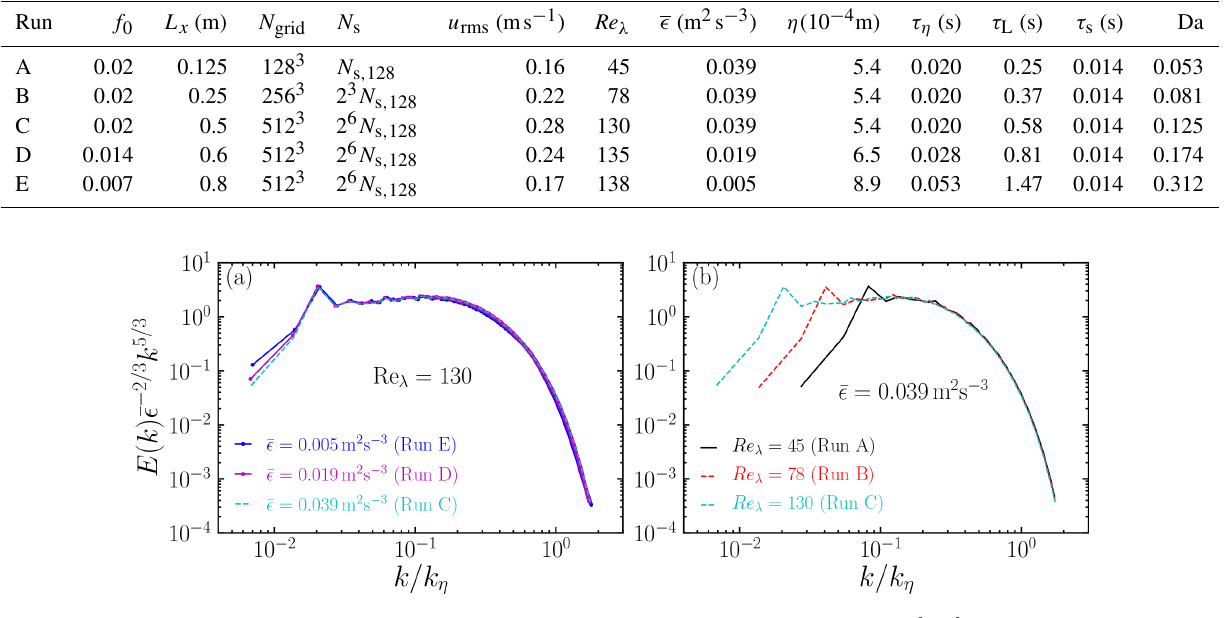
Figure 1. Time-averaged kinetic-energy spectra of the turbulence gas flow for (a) different (cid:15) = 0 . 005m 2 s − 3 (dash-dotted blue line), 0.019 (dash-dotted magenta line), and 0.039 (dashed cyan line) at fixed Re λ = 130 (see runs C, D, and E in Table 2 for details) and for (b) different Re λ = 45 (solid black line), 78 (dashed red line), and 130 (dashed cyan line) at fixed (cid:15) = 0 . 039m 2 s − 3 (see runs A, B, and C in Table 2 for